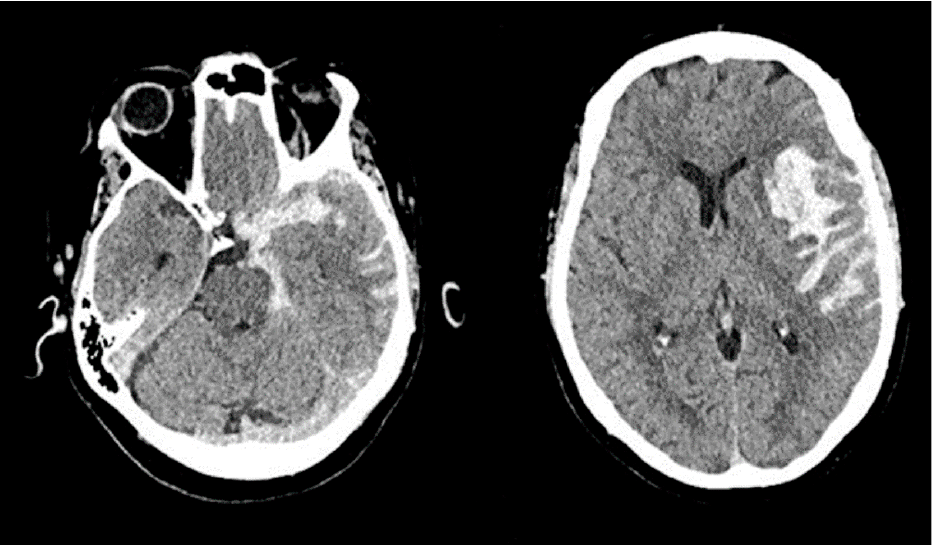
Figure 5. Case 3: Head Computed Tomography Showing Frontal Intraparenchymal Hemorrhage with Left Sylvian Fissure Extension. Table 3. Case 3: IVN Dosage and Related ICP Readings.